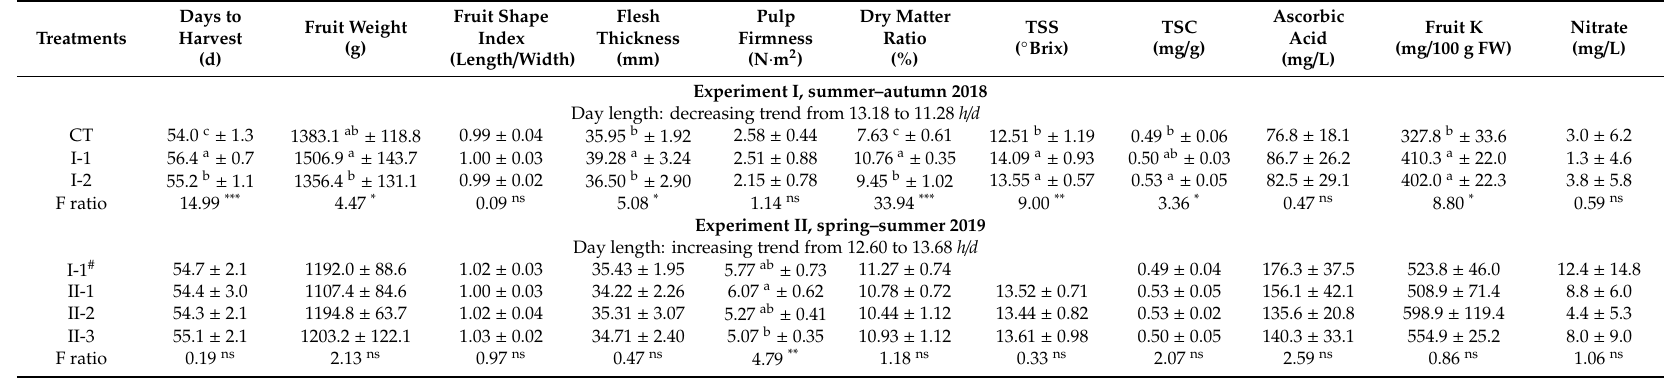
Table 3. Fruit morphological and chemical characteristics of netted melon fruits cultured from di ff erent nutrient treatments in Experiment I and II. The superscript letters indicated the results of post hoc tests. Statistical significances tested with one-way ANOVA were denoted by asterisk: p < 0.05 *, p < 0.01 **, p < 0.001 ***. Codes and details for experimental treatments refer to Tables 1 and